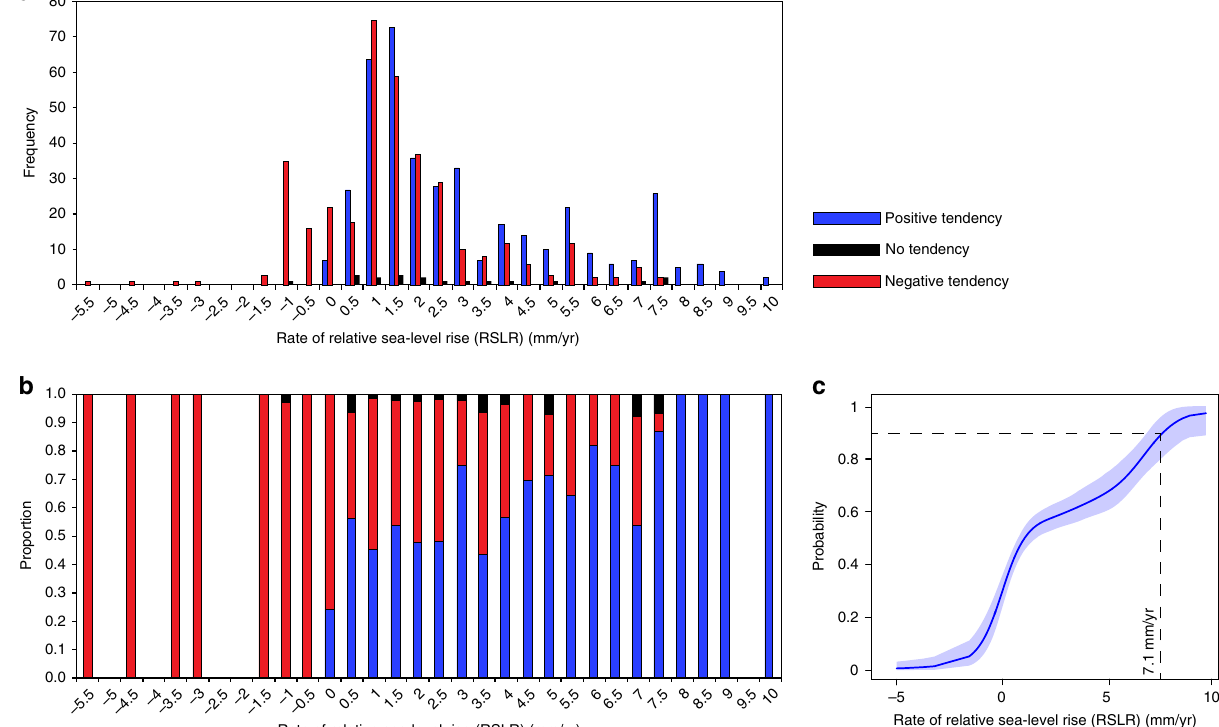
Fig. 2 Rates of relative sea-level rise for positive, negative, and no tendency sea-level tendencies. a Histogram of number of positive, negative, and no tendency sea-level tendencies for rates of relative sea-level rise (RSLR; 0.5 mm/yr bins); b Proportion of positive, negative, and no tendency sea ‐ level index points, recording marsh retreat, marsh expansion, and marsh keeping pace with RSLR, respectively, for rates of RSLR (0.5 mm/yr bins); c Probabilities of having positive sea-level tendency associated with different rates of Holocene RSLR. Note: no index points in the data set occur outside of the range